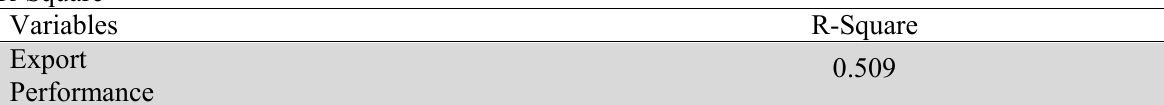
Test of Reliability Variables